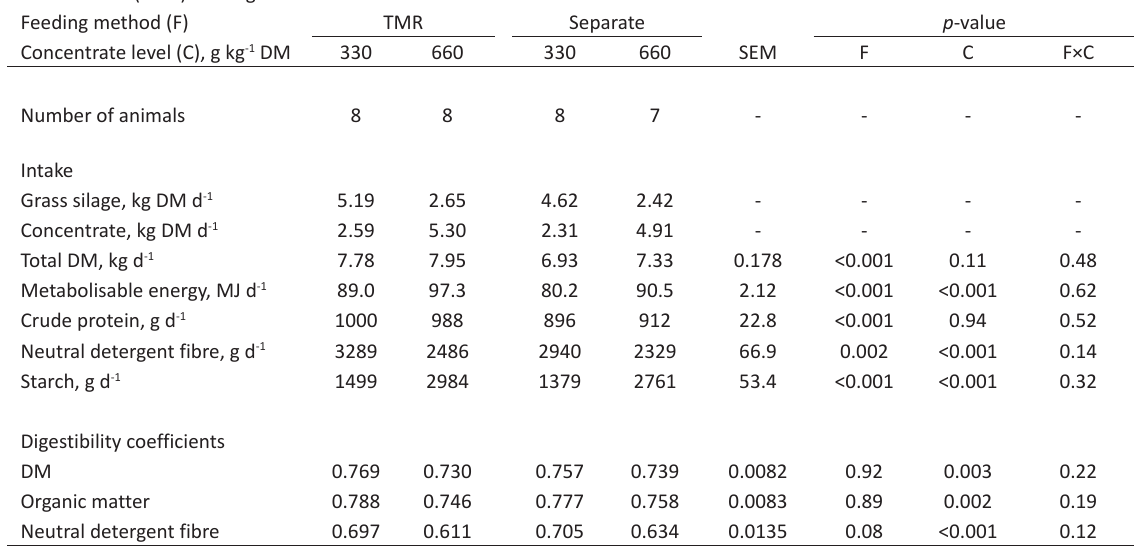
Table 3. Growth performance, feed conversion and carcass characteristics of the growing bulls fed either separate or total mixed ration (TMR) feeding with two different concentrate levels. Feeding method (F) TMR Separate p -value Concentrate level (C), g kg -1 DM 330 660 Initial live weight, kg Carcass weight,